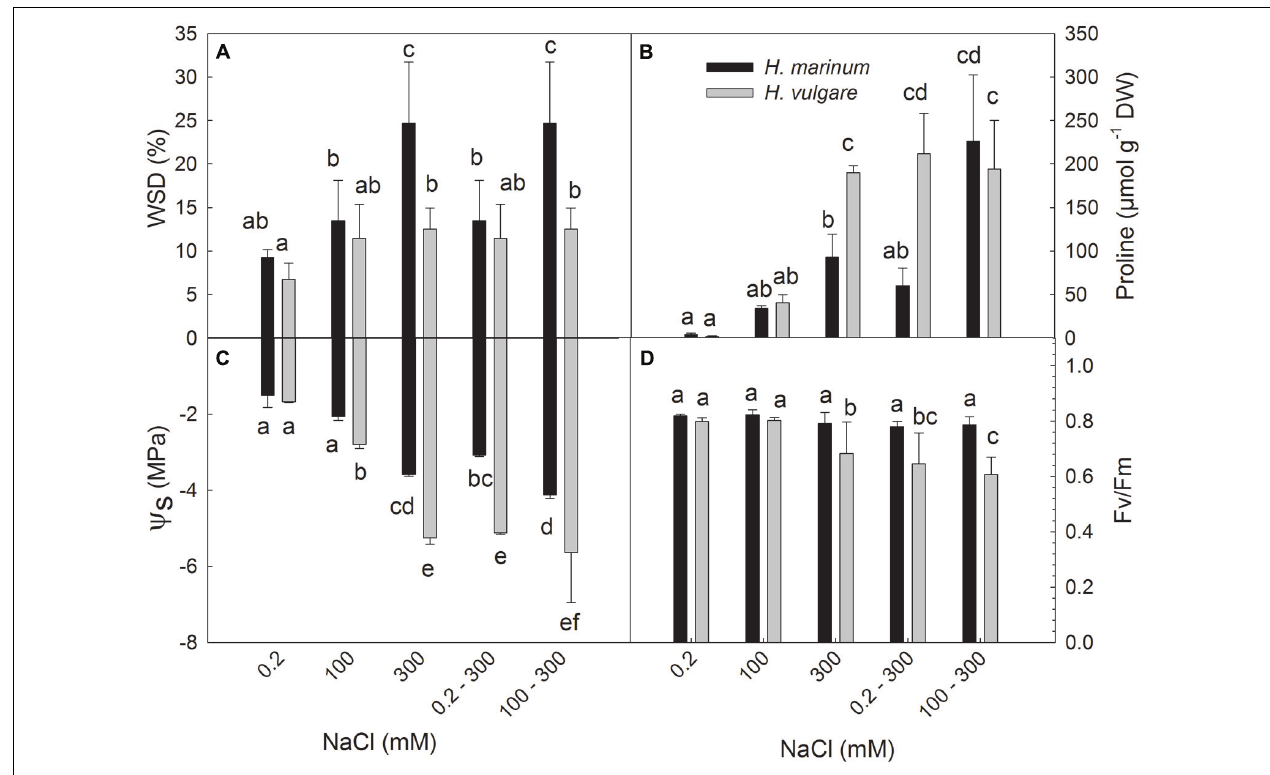
FIGURE 1 | Water saturation deficit (WSD; A), proline accumulation (B), osmotic potential ( ψ s ; C) and maximum quantum yield of photosystem II photochemistry ( F v / F m ; D) determined in leaf tissues of Hordeum marinum (black columns) and H. vulgare cv. Tadmor (gray columns). Different letters above the columns indicate significant differences between the variants determined by ANOVA, multiple comparisons, Duncan’s multiple range test at 0.05 level.